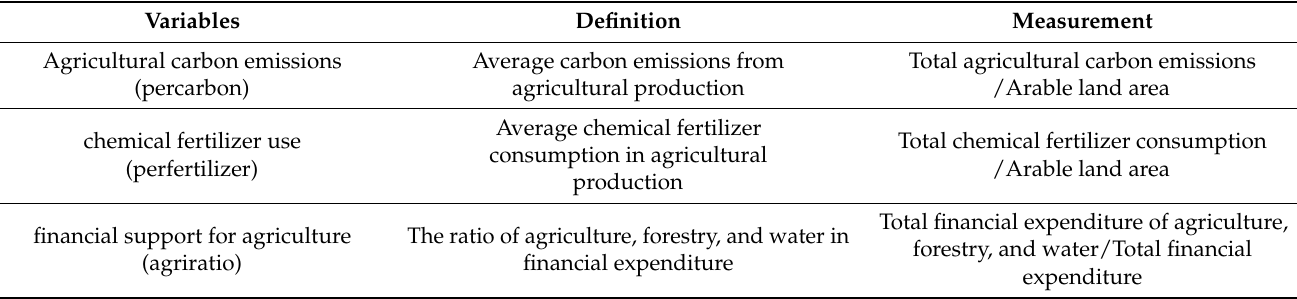
Table 2. The definition and measurement of